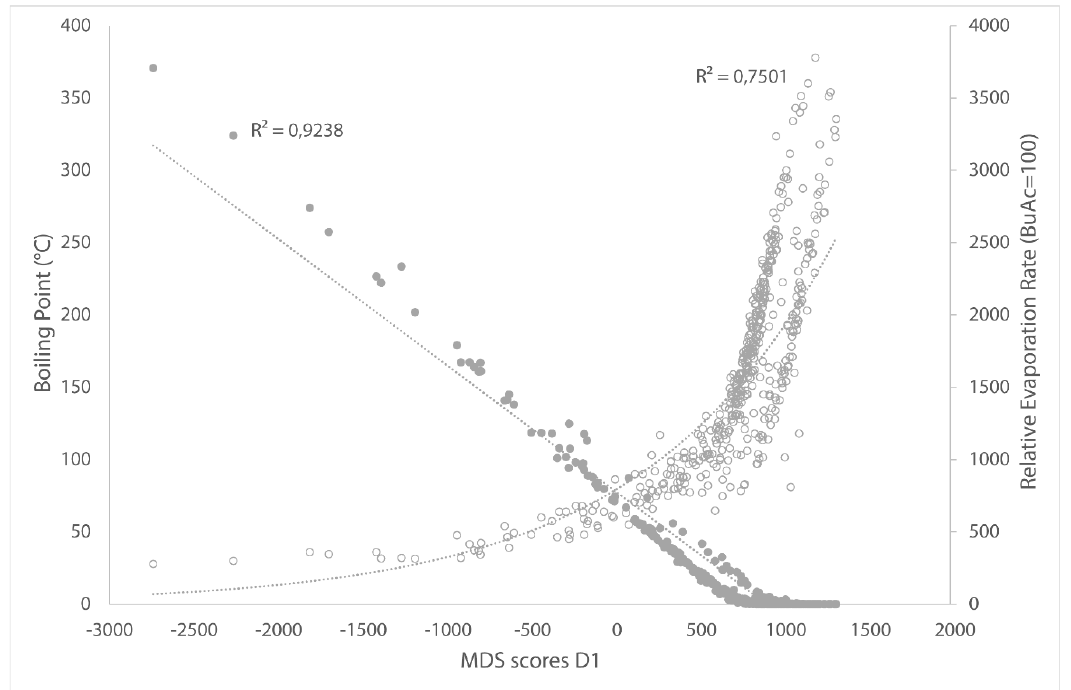
Figure 2. Correlations between D1 from MDS plot and boiling point and relative evaporation rate. Filled dots represent relative evaporation rate, whereas empty dots show boiling point.